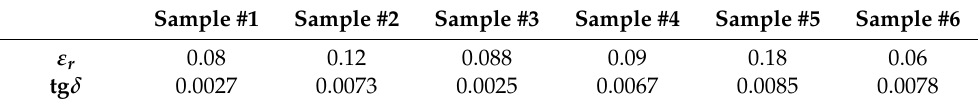
Table 6. Average of value differences for light and strong pressure on substrate samples.